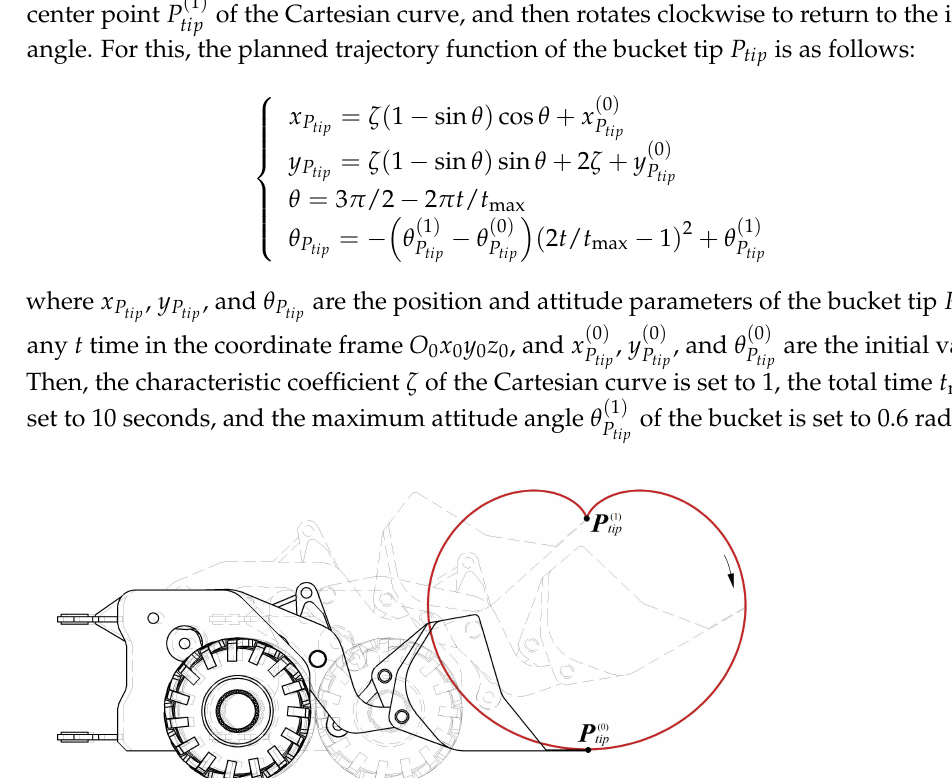
1.38 × 10 − 4 m with a maximum absolute error of 2.48 × 10 − 4 m, not exceeding 0.04‰ of the x coordinate of the planned trajectory. The average absolute error of the y coordinate of the calculated trajectory is 5.22 × 10 − 5 m with a maximum absolute error of 1.14 × 10 − 4 m, not exceeding 0.05‰ of the y coordinate of the planned trajectory. These errors can be neglected; thus, the accuracy of the kinematic model is